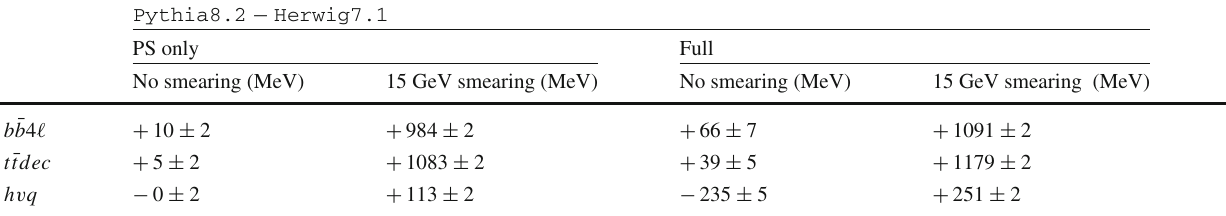
Table 9 Differences between Pythia8.2 and Herwig7.1 in the extracted m Wb peak position for m t = 172.5 GeV obtained with the j three different generators, at the NLO+PS level (PS only) and includ- Pythia8.2 −